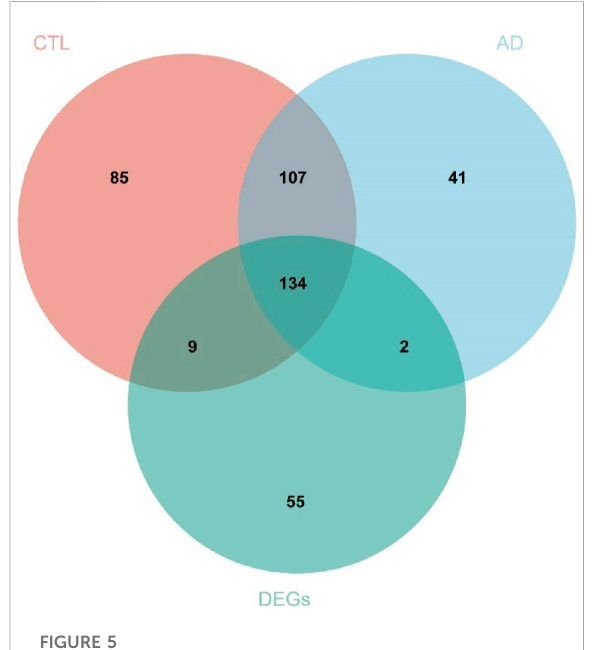
FIGURE 5 A total of 134 DEGs were screened for further analysis. Red represents 335 genes in the module with the strongest correlation to the CTL group, blue represents 284 genes in the module with the strongest correlation to the AD group, and the green represents 200 genes obtained from differential expression analysis. Abbreviations: AD (Alzheimer ’ s Disease), CTL (Healthy Control), DEGs (Differential Expressed Genes).